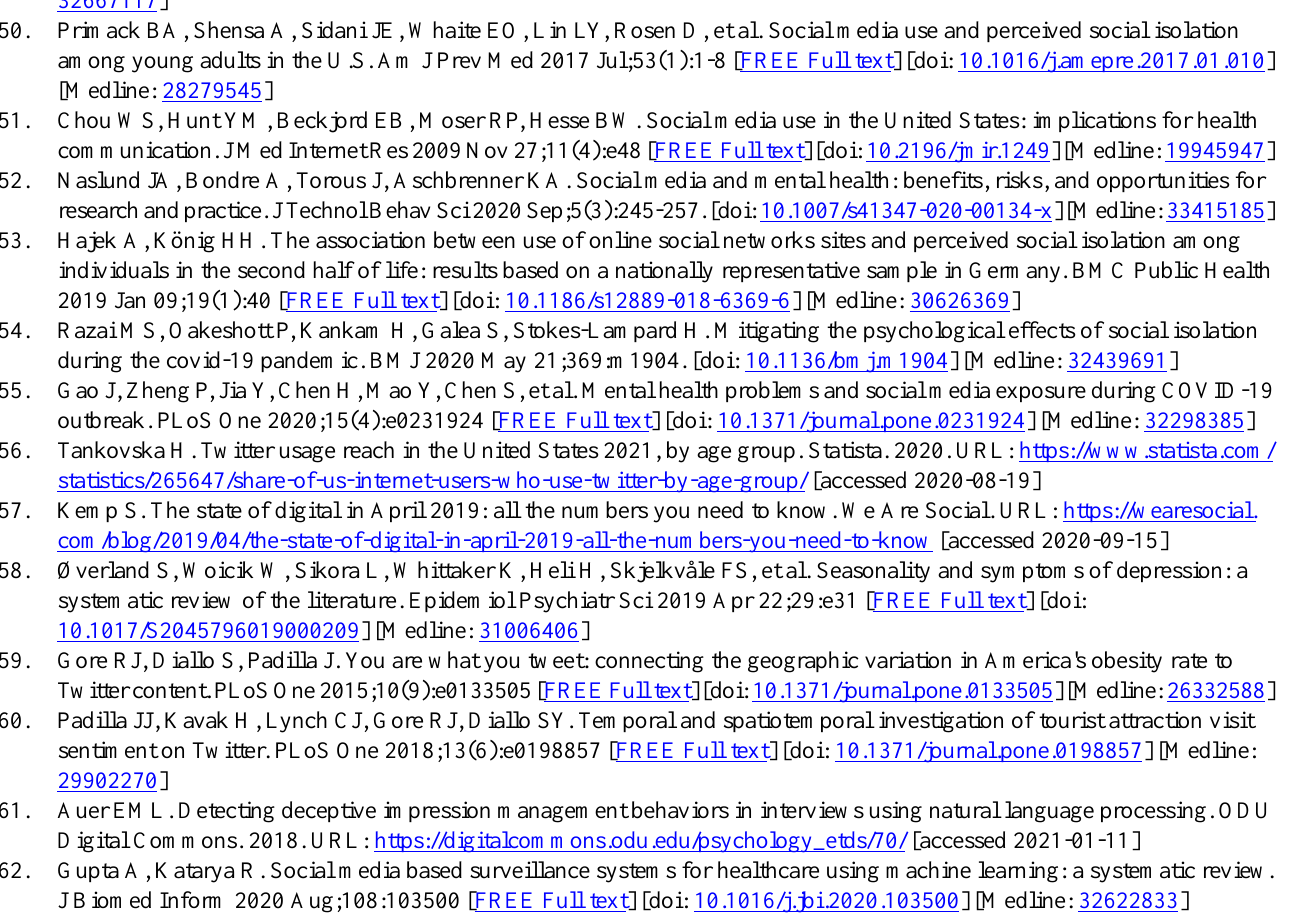
API: application programming interface PHQ-8: patient health